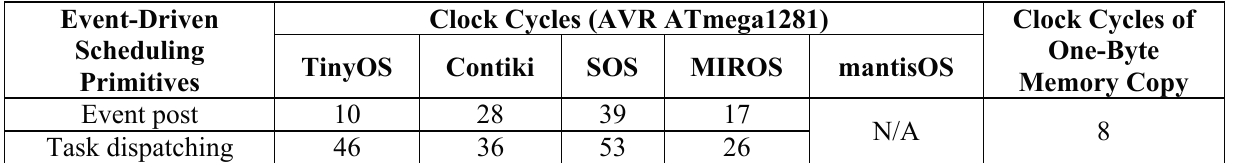
Table 2. Clock cycles of the event posting and task dispatching primitives in different schedulers. Event-Driven